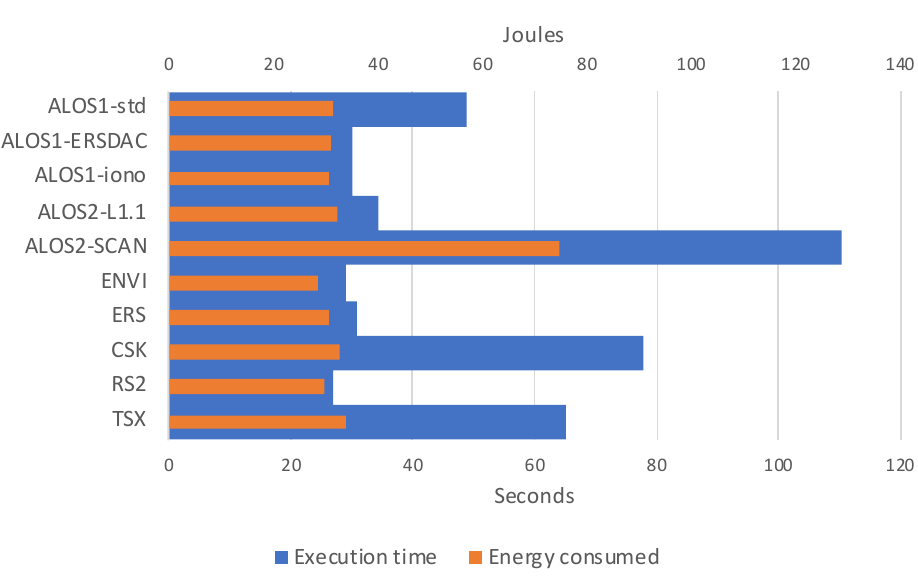
Figure 12. Graphical representation of the execution times for considered datasets on Jetson Nano hardware configuration set on 10-watt power mode, and relative joules of energy